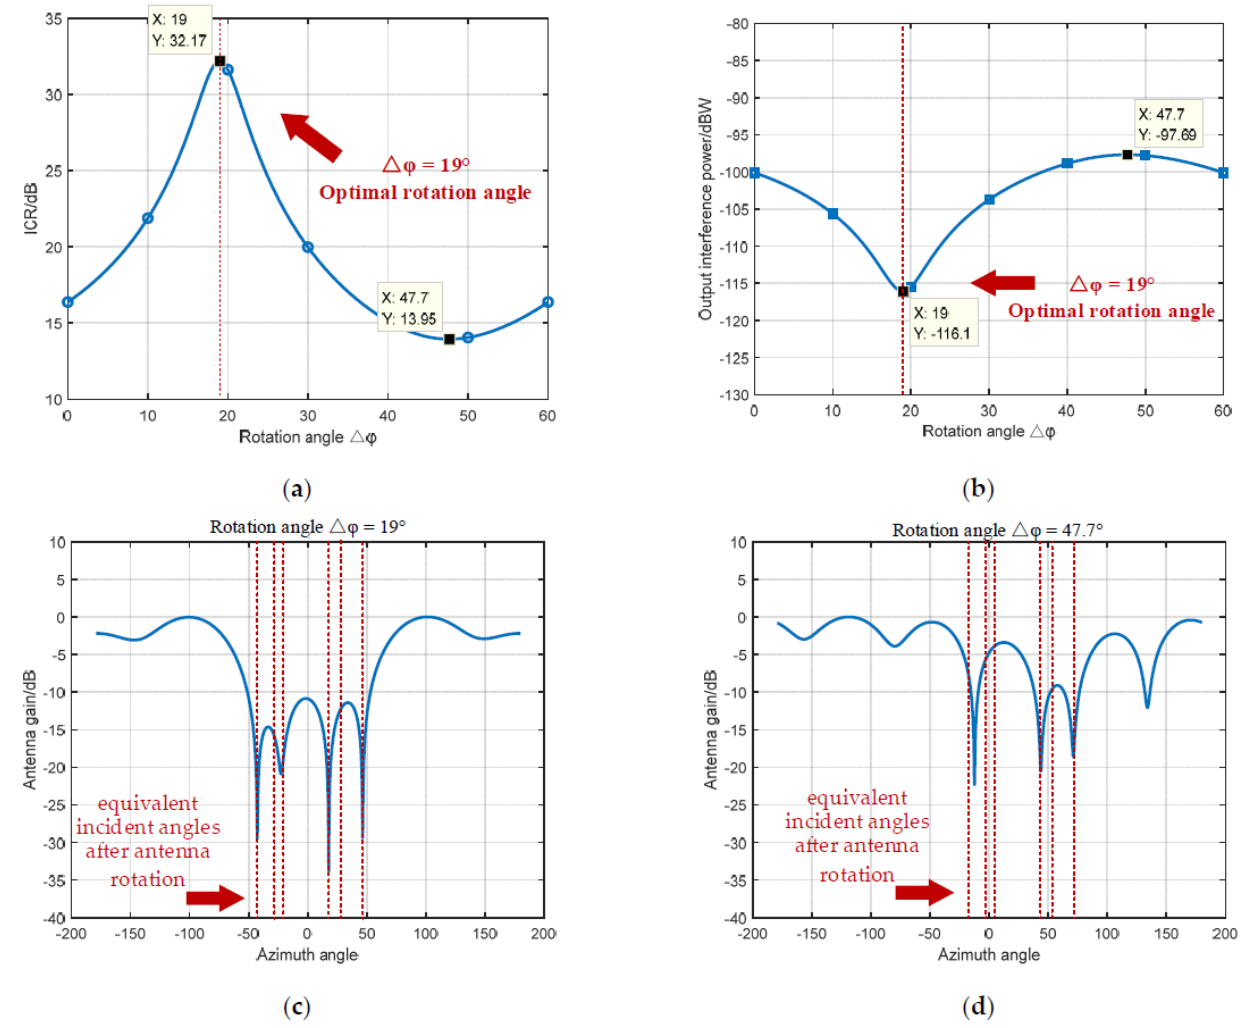
Figure 3. Relationship between antenna array attitude and anti-jamming performance. ( a ) ICR against rotation angle. ( b ) Residual interference power against rotation angle. ( c ) Antenna pattern at ∆ ϕ = 19 ◦ . ( d ) Antenna pattern at ∆ ϕ = 47.7 ◦